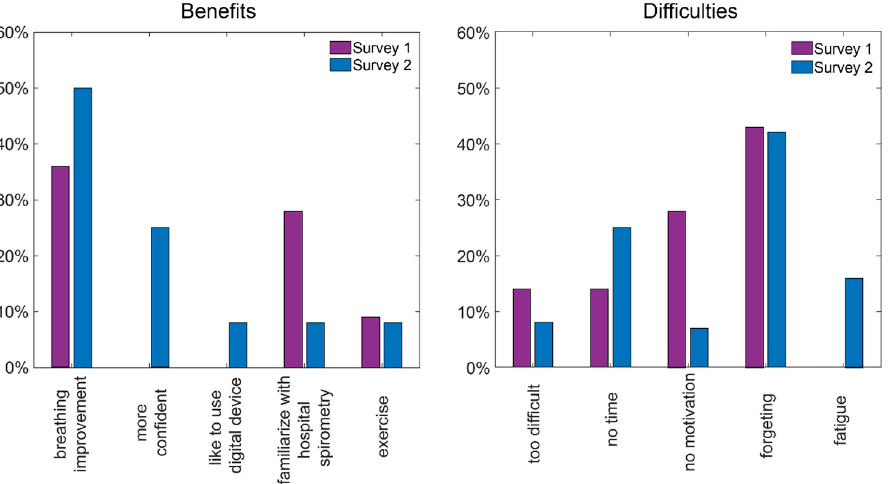
Figure 4. Benefits of telemonitoring of pulmonary function and reasons for irregular measurements reported by participants.